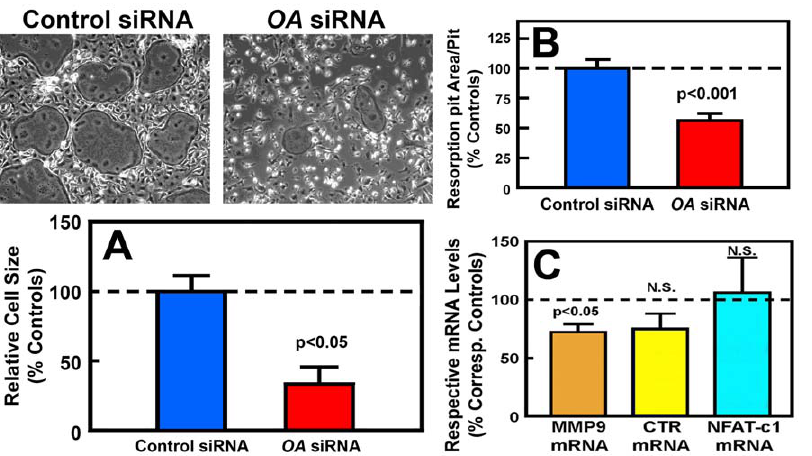
Figure 9. Effects of siRNA-mediated OA suppression on average cell size (A), invitro bone resorption activity (B), and expression of osteoclastic genes (C) in RAW264.7 cell-derived osteoclast-like cells. The dosage of OA siRNAs (29 pM) used in this experiment suppressed OA expression in RAW264.7 cells by greater than 70% (data not shown). RAW264.7 cells were treated with OA siRNAs or control siRNA in the presence of RANKL for 5 days. A shows the relative size of the derived TRAP positive, multinucleated osteoclast-like cells. Top is a representative photomicrograph of the derived osteoclast-like cells, and bottom summarizes the relative size (in relative percentage of the control siRNA-treated cells). B shows the bone resorption activity of the derived osteoclast-like cells determined by an in vitro resorption pit formation assay; and C summarizes the effects of OA siRNA on the relative expression levels of MMP9 , CALCR , and NFATc1 mRNA (determined by real-time RT-PCR and normalized by the respective expression level of b -actin). Results are shown as percentage of respective control siRNA-treated RAW264.7 cell-derived osteoclast-like cells and in mean 6 SEM (n=3 or 4 for each parameter). The dashed line represents the 100% of the control siRNA-treated controls.